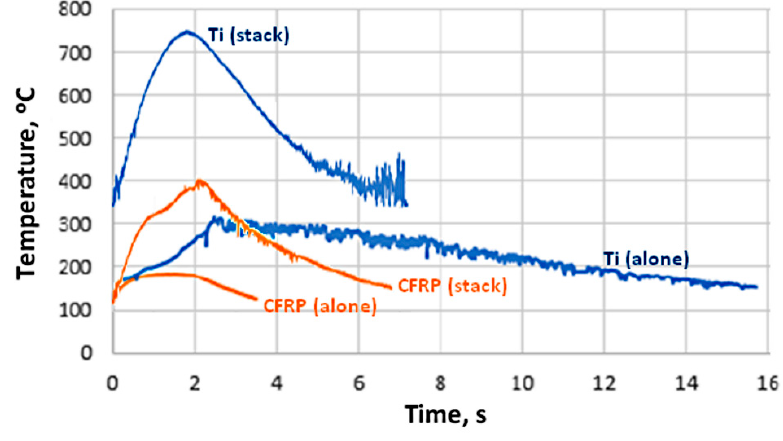
Figure 11. Temperature versus time in the CFRP and the Ti-6%Al-4%V plates, and in the CFRP/Ti-6%Al-4%V stacks (for hole 25).